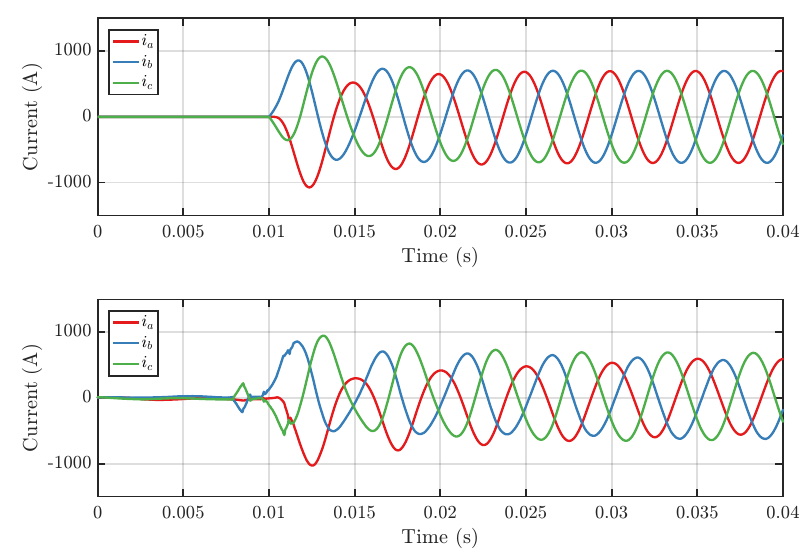
Figure 10. Three-phase short circuit at 3000min − 1 : ( top ) simulations and ( bottom ) measurements.